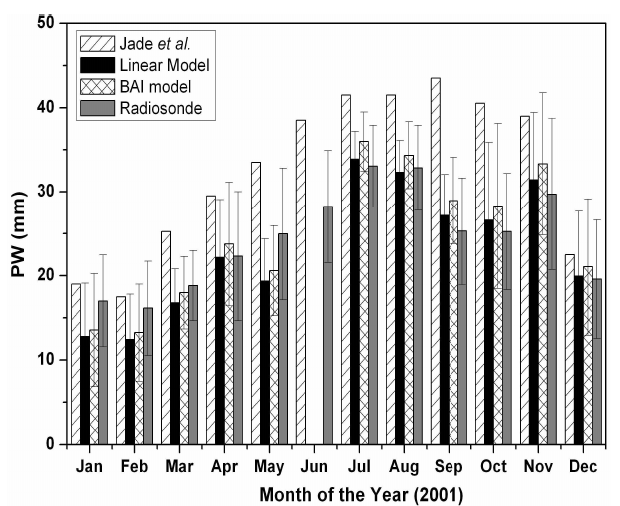
Fig. 11. Bar-chart showing a comparison of monthly mean values of PW GPS at Bangalore using site-specific linear model (Eq. 6) and BAI regional model (Eqs. 7, 8) for the year 2001 along with cor- responding values of PW derived from radiosonde data and those reported by Jade et al. (2005).